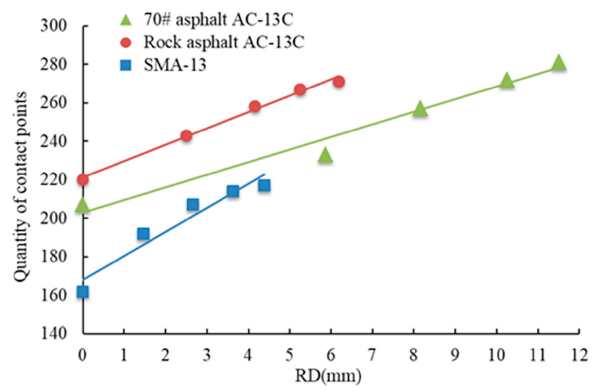
Figure 8. Relationship between contact points and RD.